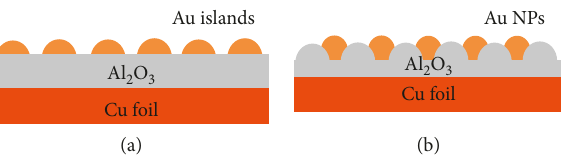
Figure 3: AFM topographical images of sputtered Au/Al after annealing